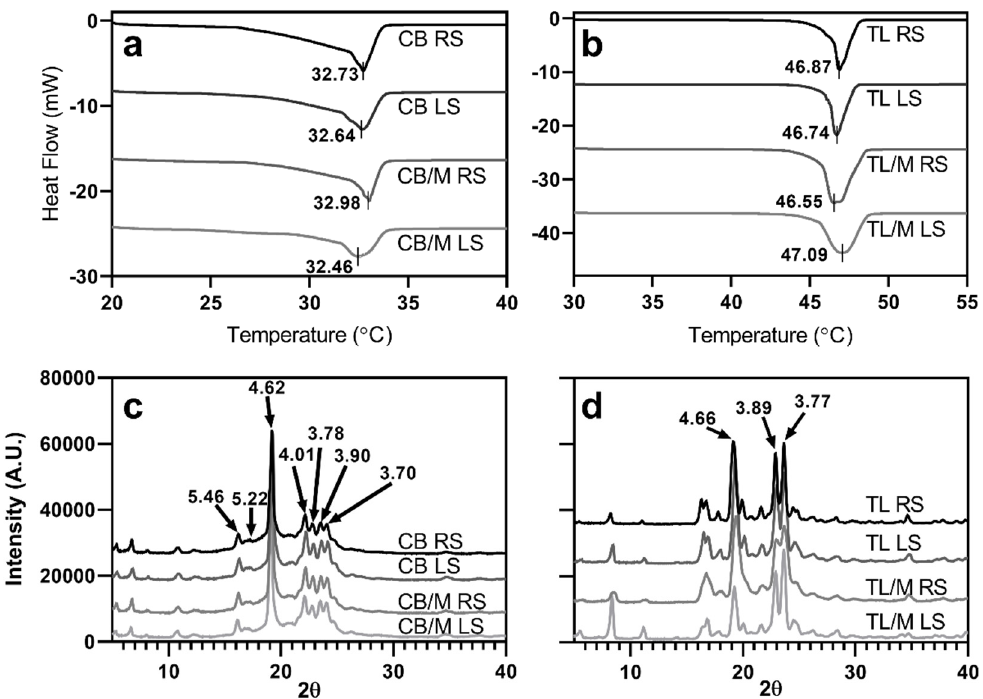
Figure 2. Plotted DSC ( a , b ) and XRD ( c , d ) data for cocoa butter and trilaurin samples. Different colored lines represent the melting profiles and diffractograms of the lipid blends. Straight lines passing through thermogram peaks with corresponding temperatures represent the melting point temperatures for respective samples. Values with corresponding arrows pointing to peaks in sample diffractograms represent d-spacings between planes of symmetry measured in angstroms ( Å ). Plots for DSC and XRD were created by plotting replicates that were most representative of the average observed melting profile and diffractogram, respectively.